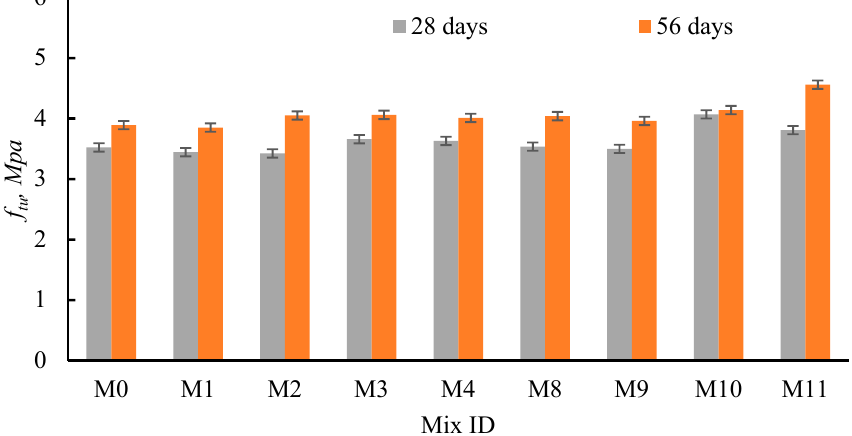
Figure 10. Effects of the RFCA and RFNA on concrete diagonal strength.